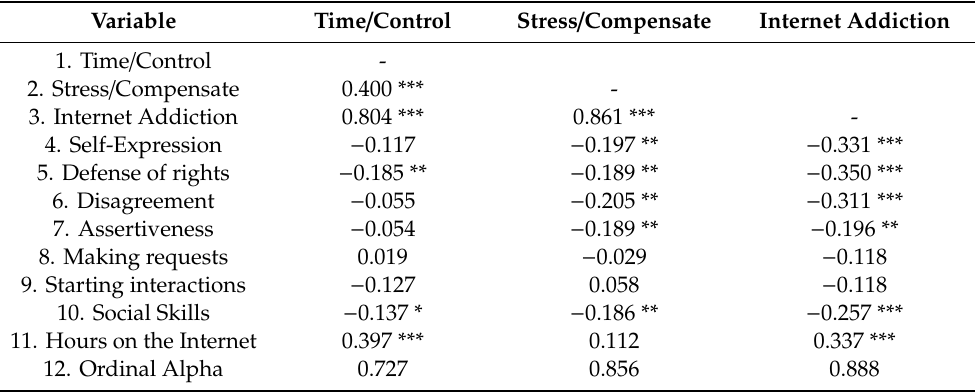
Table 5. Interfactorial matrix, convergent evidence, and reliability of the